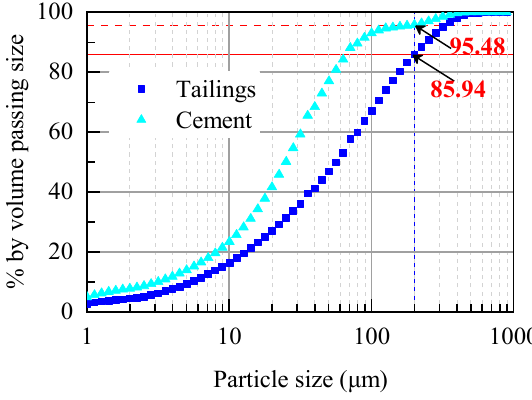
Figure 1. PSDs of tailings and cement. Table 2. PSD of the coarse aggregates.